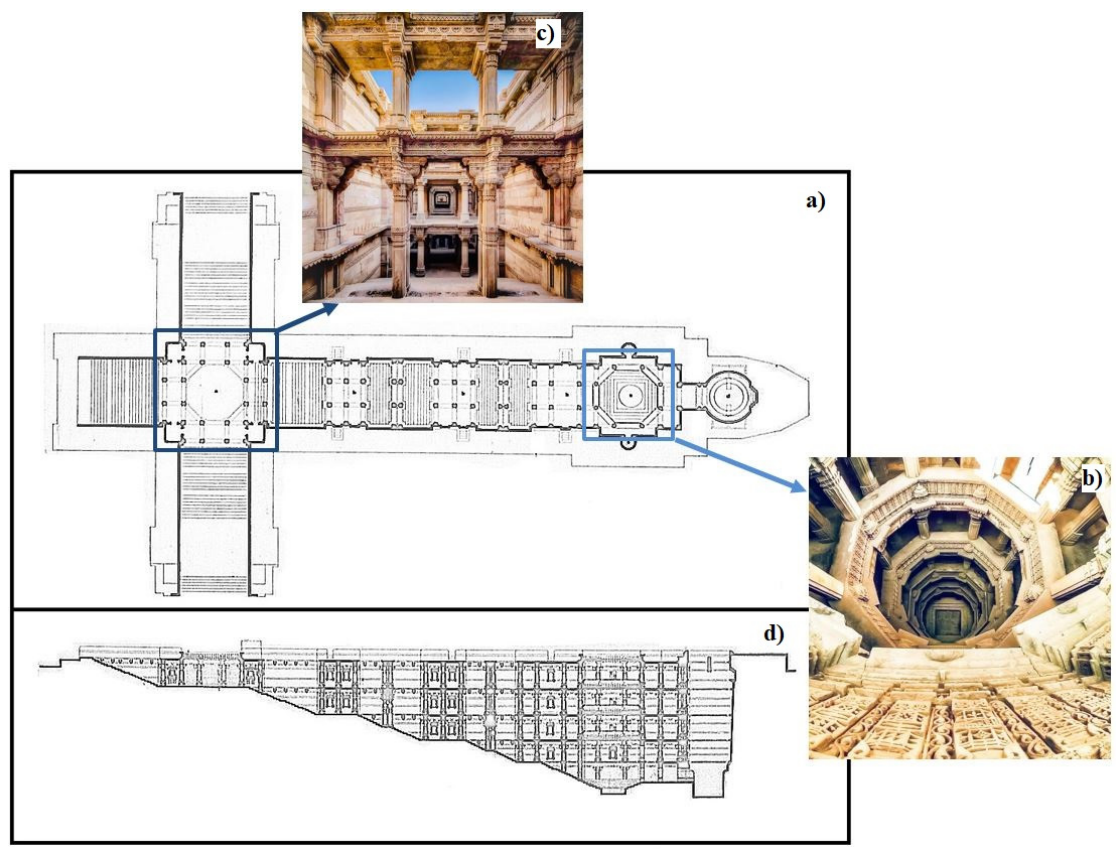
Figure 11. Adalaj Vav. ( a ) Plan https://hkblabla.wordpress.com/2011/09/12/step-well-getrapt-water- reservoir/amp/, accessed on 20 July 2022; ( b ) cross-section at entrance https://www.facebook. 2022; ( c ) cross-section at junction of well